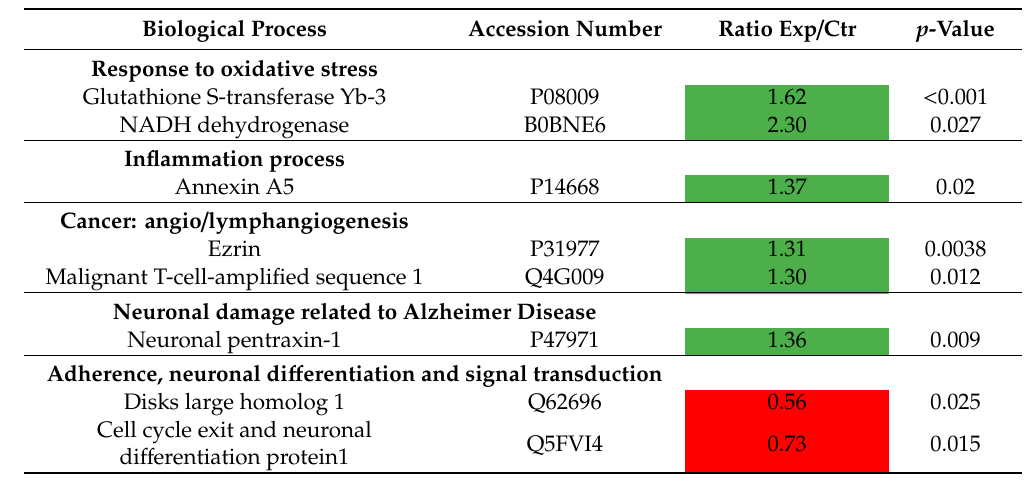
Table 4. Examples of dysregulated proteins in the brain following exposure to Iron NPs and related biological processes. The data were generated from TargetMine software: Biological process name, protein name, protein accession number, ratio exposed (Exp) / control (Ctr), p -value ratio. Up-regulated proteins are highlighted in green color and down-regulated proteins in red